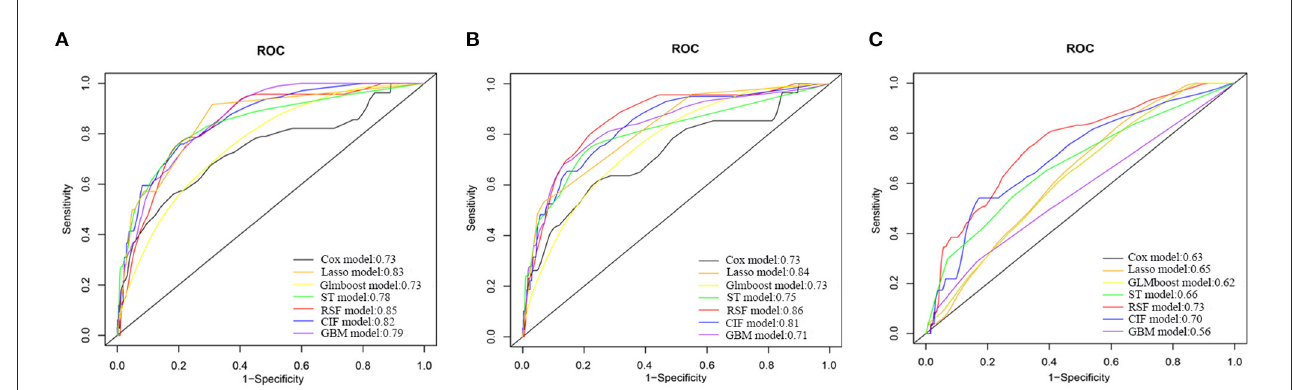
FIGURE1 Receiver operating characteristic curves of different models for predicting 6-year all-cause mortality in Internal Validation Cohort. (A) Models with all variables. (B) Models with variables excluding laboratory variables. (C) Models with only laboratory variables. COX, Cox proportional hazards regression model; Lasso, least absolute shrinkage and selection operator regression model; GLMBoost, boosted generalized linear model; ST, survival tree model; CIF, conditional inference forest model; RSF, random forest survival analysis model; GBM, gradient boosting